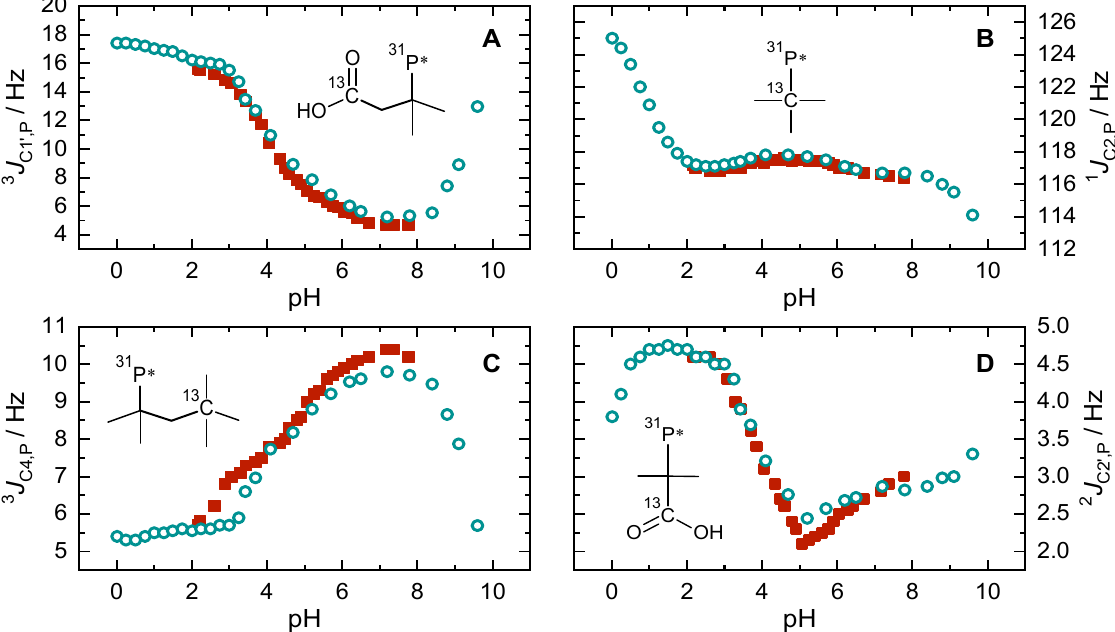
Figure 5. Graphs showing scalar 13 C– 31 P spin–spin coupling constants (absolute values) in dependence on pH/pD. ( A ) 3 J (C1 ′ –P), ( B ) 1 J (C2–P), ( C ) 3 J (C4–P), and ( D ) 2 J (C2 ′ –P). Red squares correspond to pH-titrations series of 25 mM PBTC in 0.5 molal NaCl 90/10 (v/v) H 2 O/D 2 O solutions, and blue circles correspond to pD-titration series of 350 mM PBTC in D 2 O solution without background electrolyte. Inserts sketch the respective considered coupling pathways. P* denotes the phosphonate group.